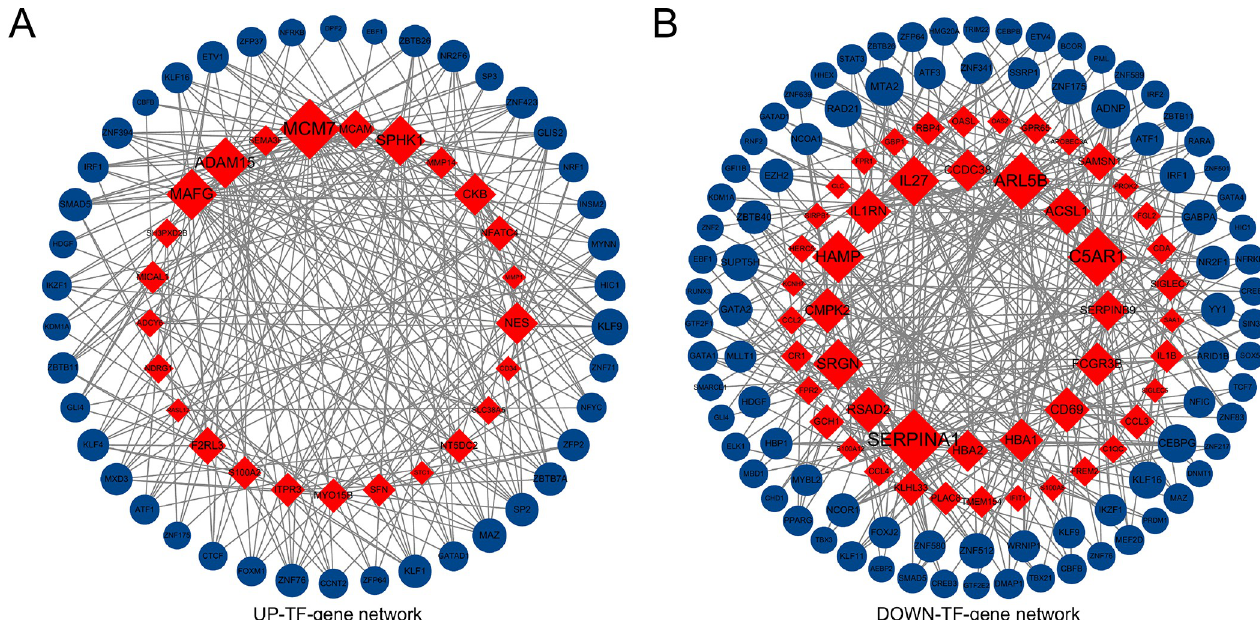
Fig 7. Network of TF-genes interacting with common differentially expressed genes. The highlighted red nodes represent common genes and the other nodes represent TF-genes.